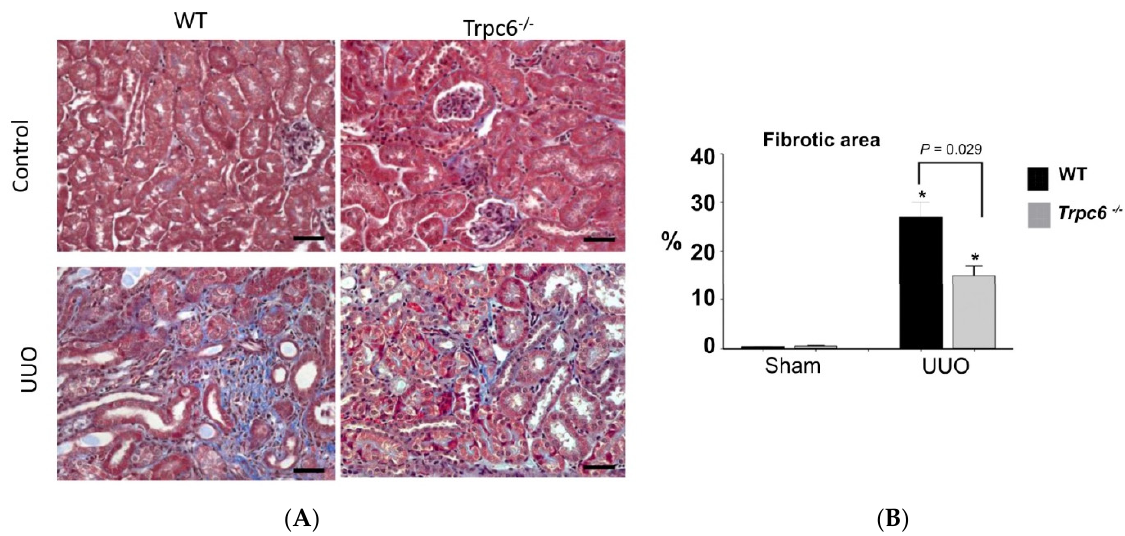
Figure 5. Reduction in renal fibrosis in Trpc6 − / − mice following unilateral ureteral obstruction. ( A ) Histological analysis based on Masson’s trichrome stain. ( B ) Quantitative analysis of this type of experiment from many animals. Asterisks indicate p < 0.05 compared to sham. Modified from [64] and used with permission.